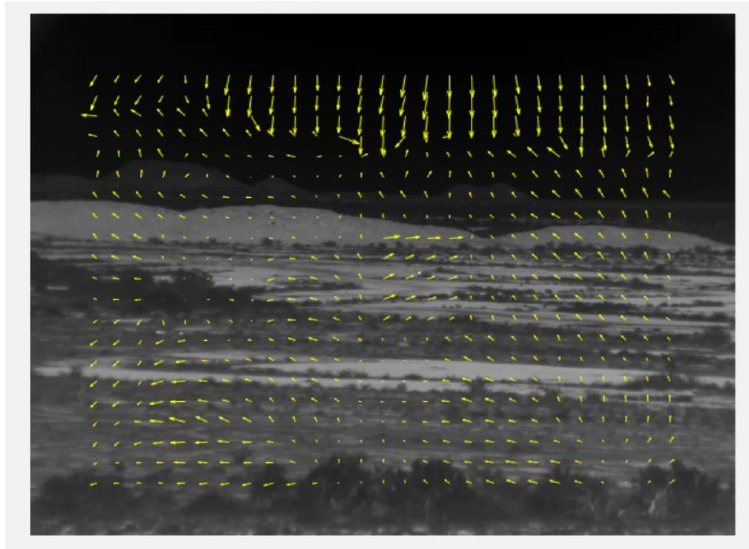
Figure 1. Lucas–Kanade (LK) optical flow between Frame 1 and 10 for 3500 m (daytime Figure 1. Lucas – Kanade (LK) optical flow between Frame 1 and 10 for 3500 m (daytime video).